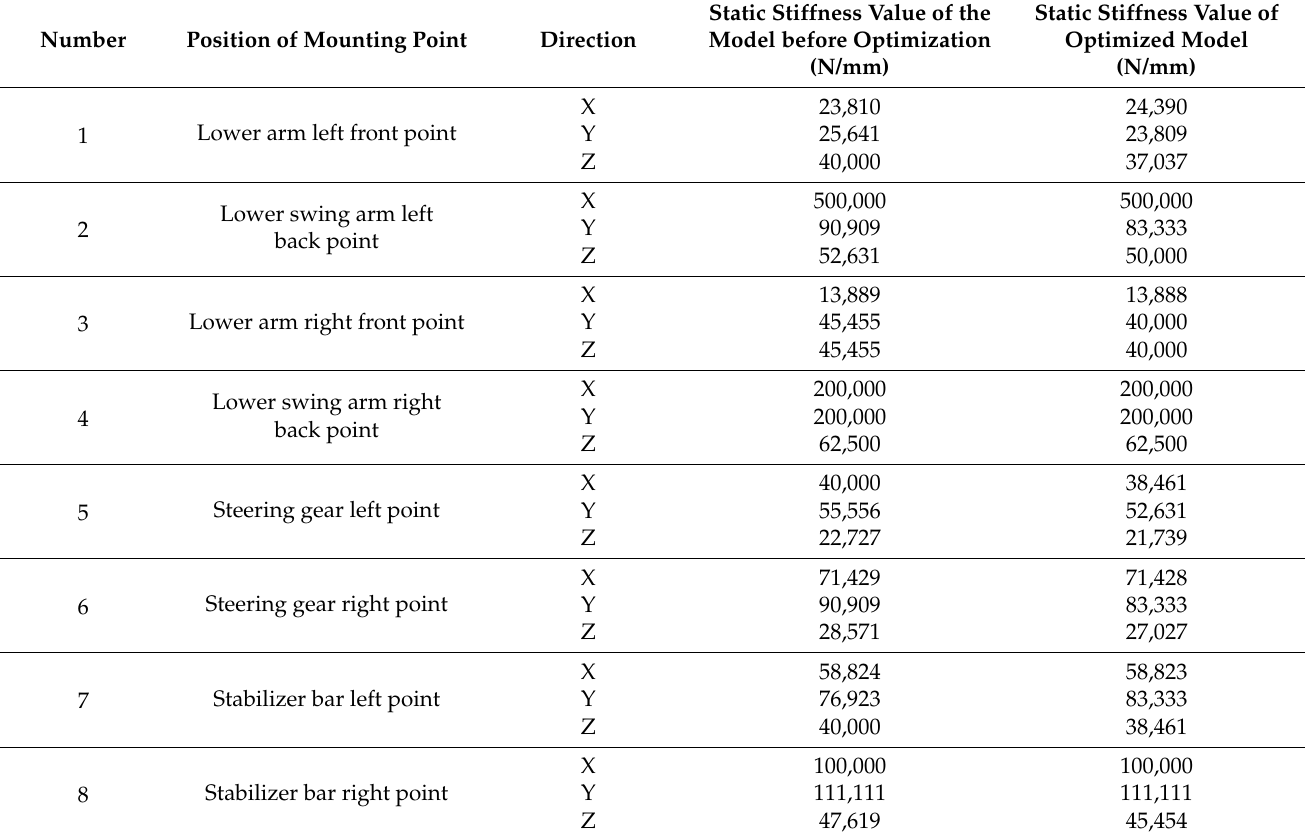
Table 7. Comparative analysis results of static stiffness performance of aluminium alloy front subframe before and after optimization.